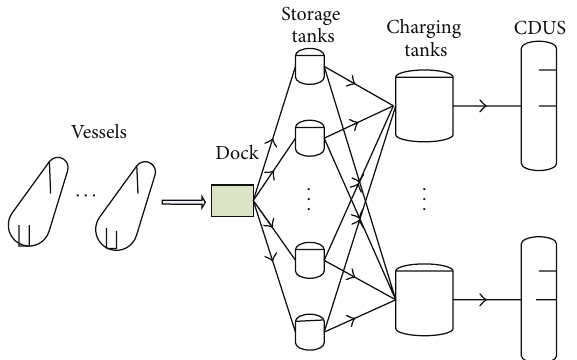
Figure 1: Typical flow process for the refinery crude oil